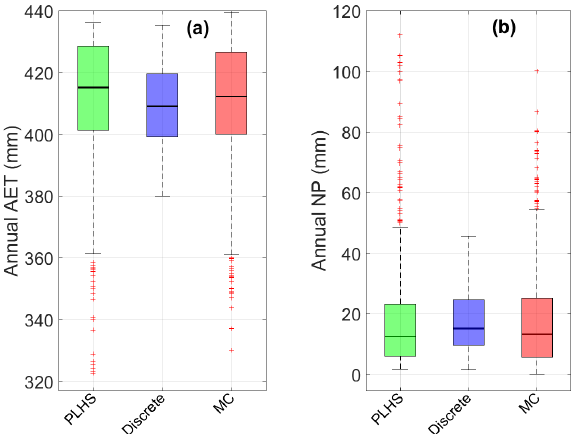
Figure A6. Box plots showing the distributions of (a) annual AET and (b) annual NP obtained from the simulated water balances for the A100 illustrative cover with 700 parameter sets for PLHS (green boxes), 135 parameter sets for discrete sampling (blue boxes), and 1000 parameter sets for MC (red boxes) over a 60-year climate cy- cle. The description of the box plots is the same as for Fig.